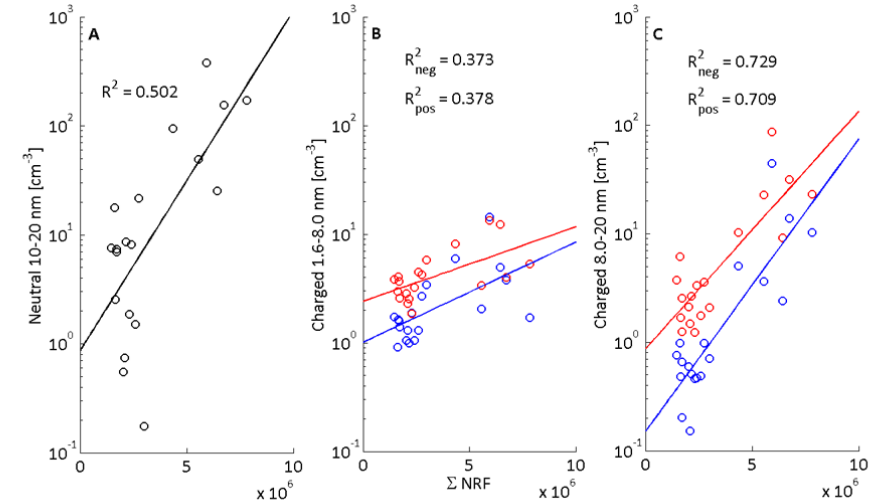
Fig. 9. The correlation between NRF and neutral 10–20nm (A) , charged 1.6–8.0nm (B) and charged 8.0–20nm (C) particles. The particle concentrations are medians over filter sampling times (2–3 days). The red and blue curves and points represent the positive and negative ions, respectively.